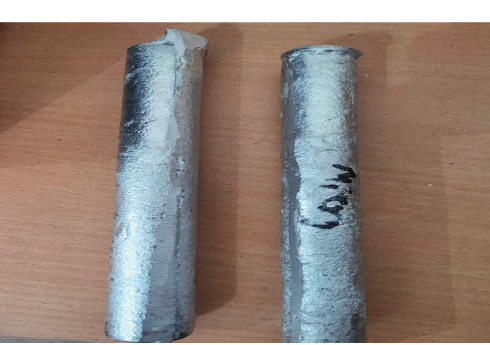
Figure 1: Casting ingot.